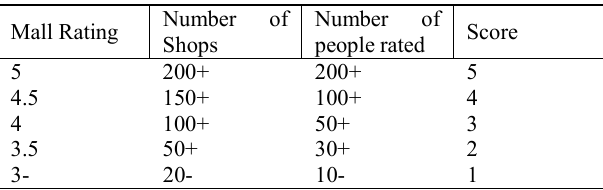
Table 3. Output rating specific criteria